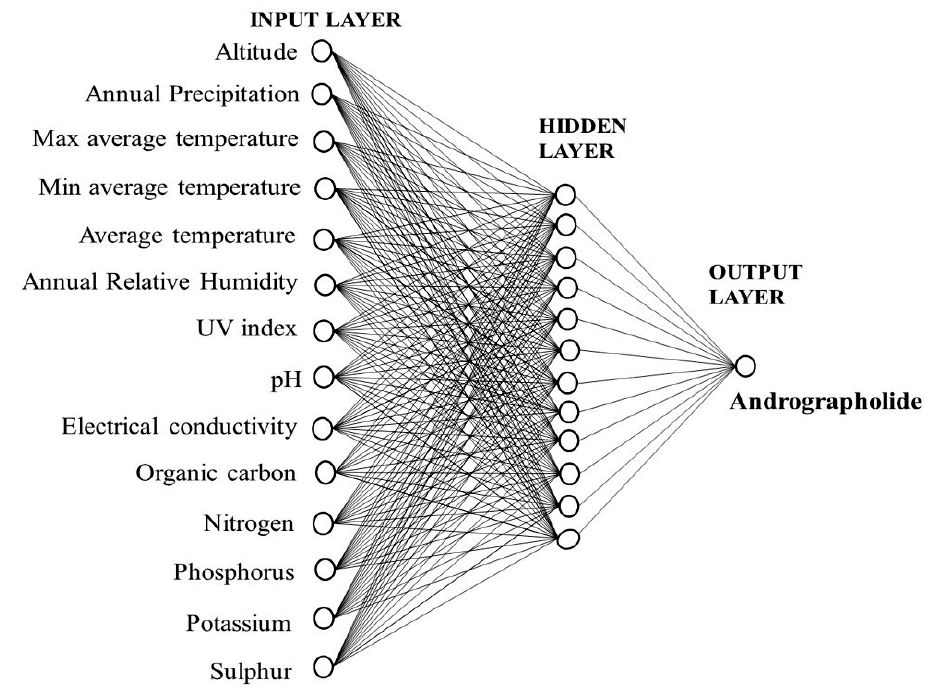
Figure 2. Architecture of the multilayer perceptron feed-forward network used in the study.